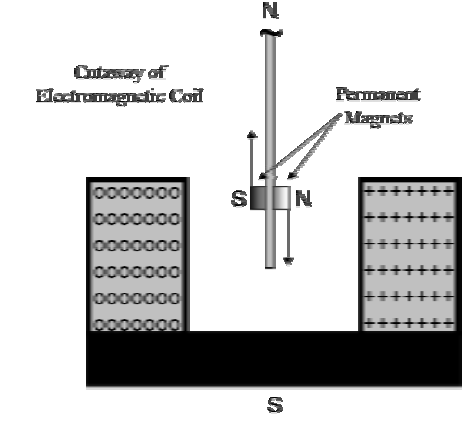
Fig. 2. Electromagnetic excitation.